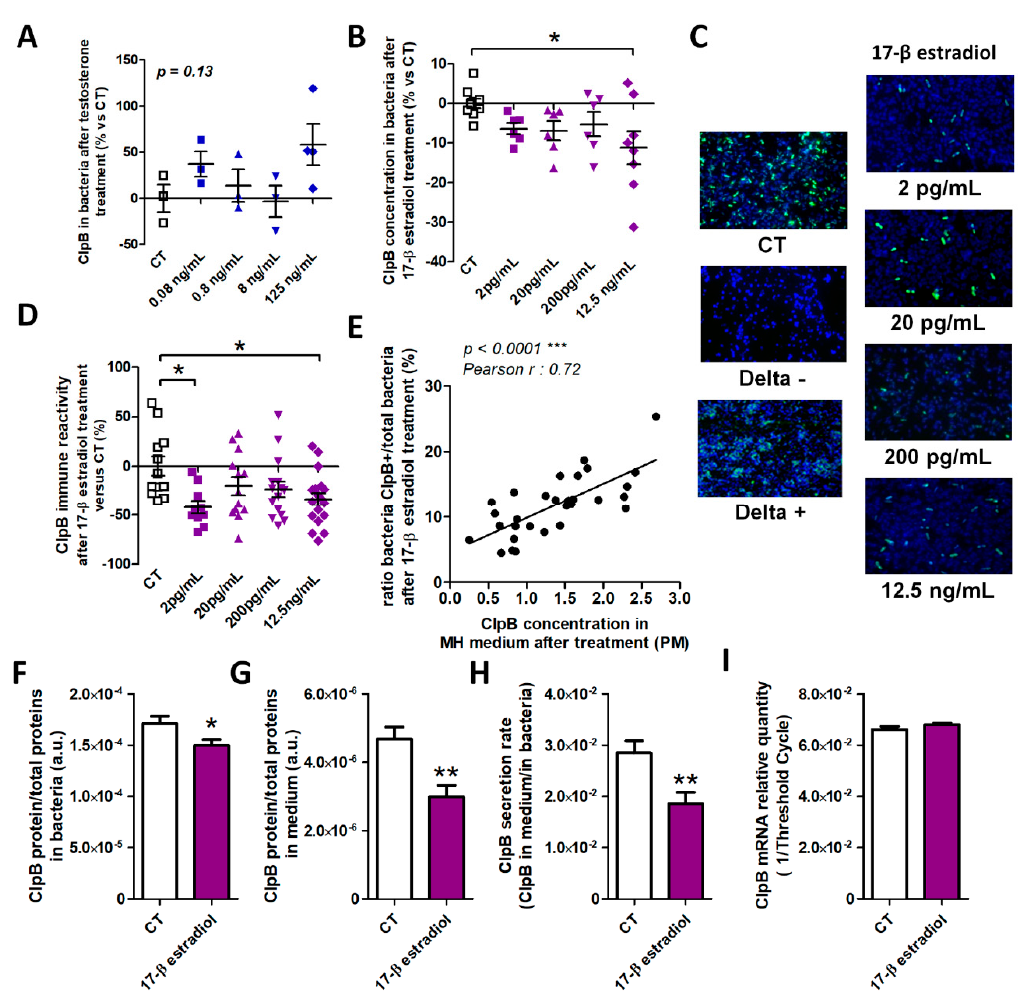
Figure 4. Effects of sex hormones on in vitro ClpB production. Changes of ClpB levels vs. control (CT) after acute application of several doses of testosterone ( A ) or estradiol ( B ) on E. coli cultures. ( C ) Immunocytochemical detection (green fluorescence) of ClpB in E. coli cultures treated with 4 doses of estradiol and in non-treated control (CT) bacteria as well as in ClpB-negative (Delta-) and -positive (Delta + ) E. coli mutant strains, DAPI counterstaining. Magnification x 100 ( D ) Percentage of changes of ClpB-positive vs. total bacteria after estradiol treatment as compared to non-treated control (CT) bacteria and ( E ) their correlations with ClpB concentrations in culture medium. Effects of chronic application of estradiol on E. coli cultures on ClpB concentrations in bacteria ( F ) and culture medium ( G ) as well as on the ClpB secretion rate ( H ) and ClpB mRNA levels ( I ). A , B , D , 1-way ANOVA, Bonferroni’s post-test * p < 0.05, ** p < 0.01 ,F,G,H , Students t-test * p < 0.05, ** p < 0.01.